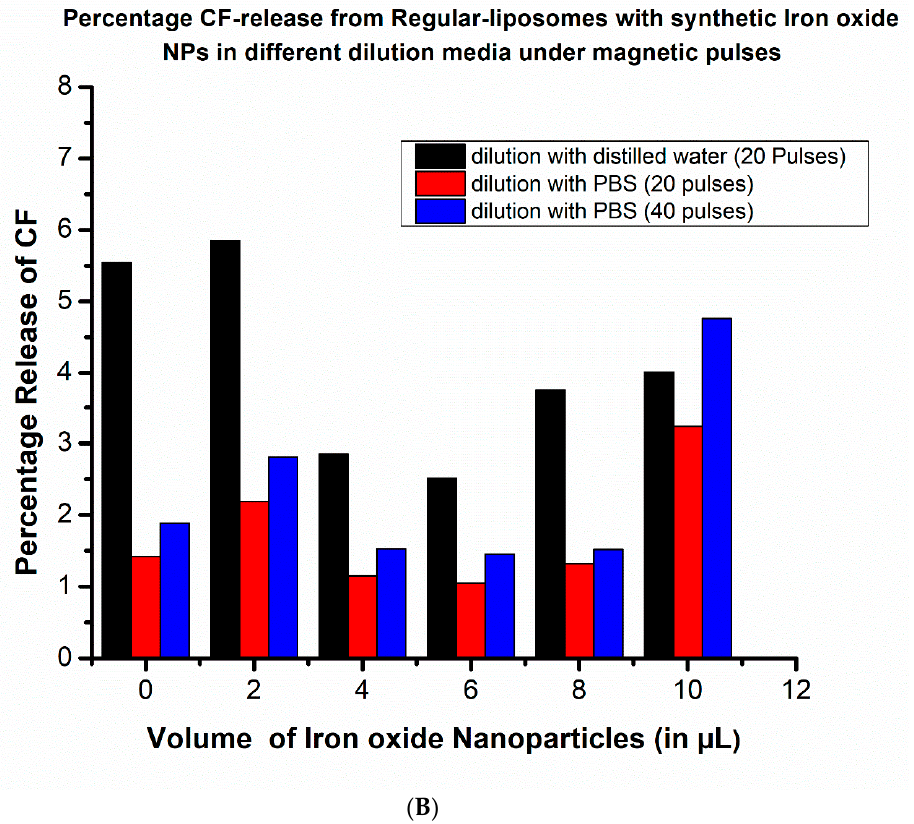
Figure 6. ( A ) Effect of dilution media on the thiolated liposome-iron oxide NP system under a pulsed magnet. ( B ) Effect of dilution media on the regular liposome-iron oxide NP system under a pulsed